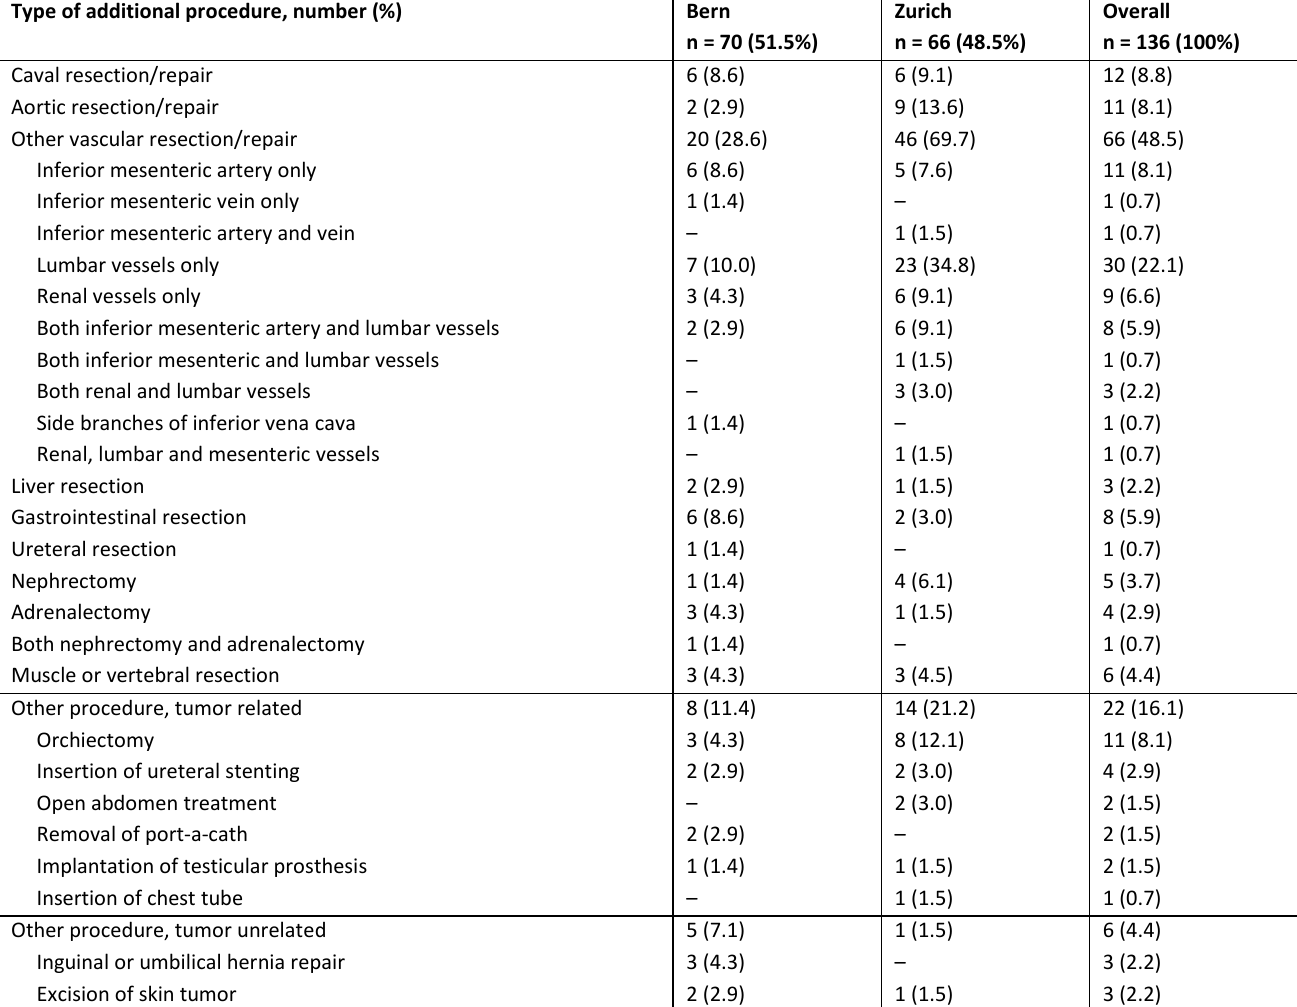
Supplementary table 4. Additional procedures during